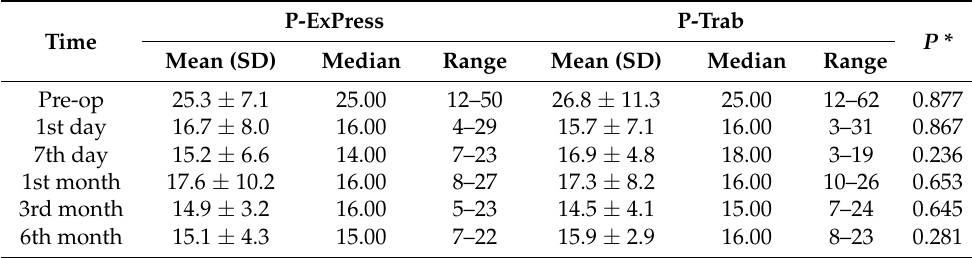
Table 2. Intraocular pressure (IOP) mean values, median values, standard deviations, and range in the phaco-Ex-Press (P-ExPress) and phaco-trabeculectomy (P-Trab) groups at specific times after